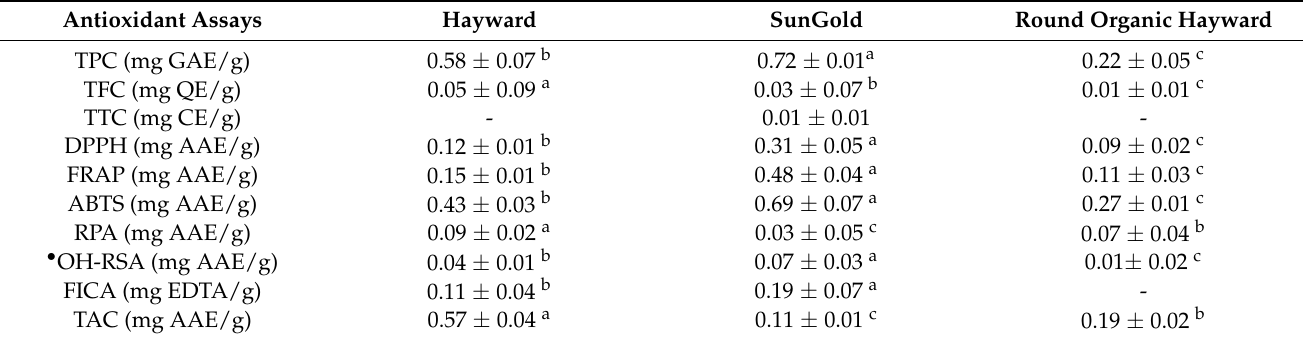
Table 1. Polyphenol content and antioxidant activity of three kiwifruit cultivars. Antioxidant